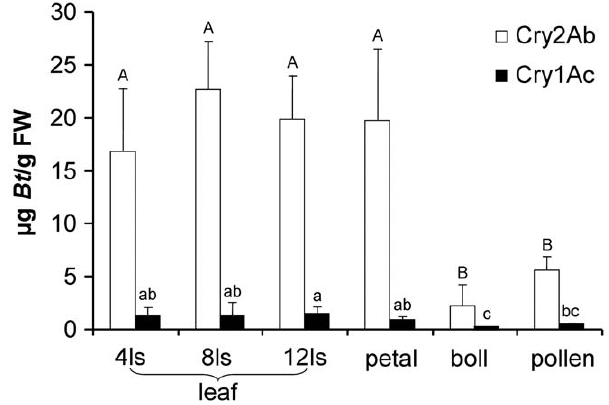
Figure 1. Concentrations (mean + SD) of Cry1Ac and Cry2Ab in Bt cotton leaves at different growing stages, petals, bolls and pollen (FW=fresh weight). Different capital letters above open bars indicate significant differences (P , 0.05) in the Cry2Ab protein concentrations. Small letters above black bars indicate significant differences (P , 0.05) in the Cry1Ac protein concentration. Treatments are significantly different from each other if they do not share the same letter. (N=3–5; ls=leaf